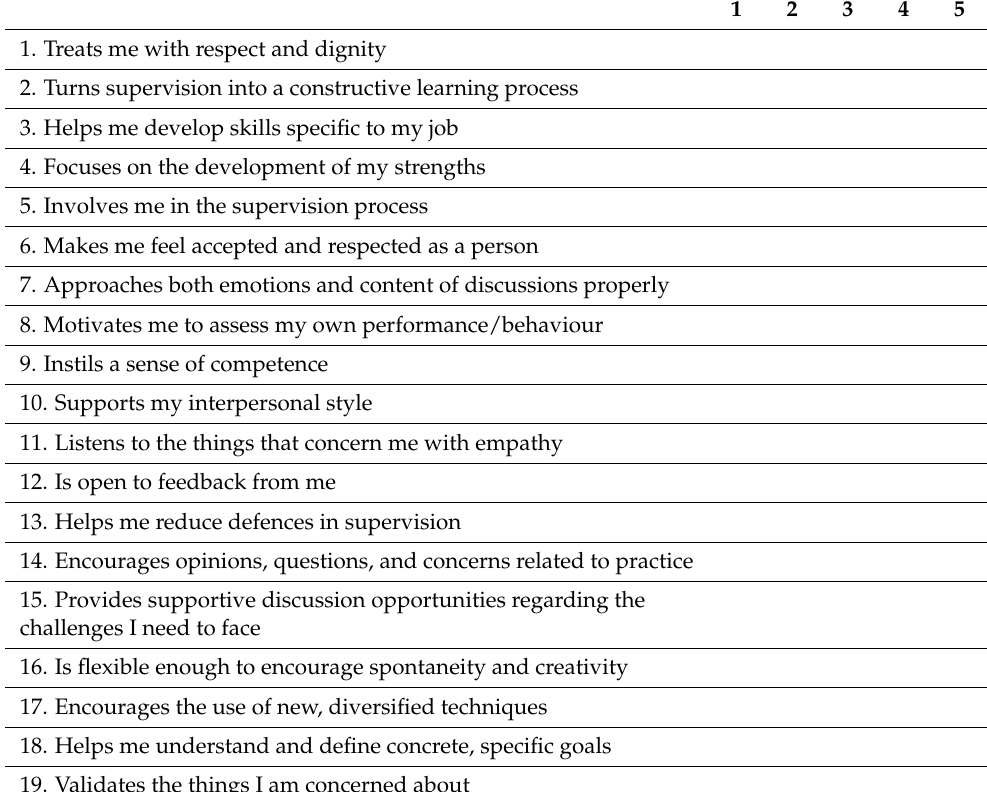
Table A2. 1—very rarely/2—rarely/3—sometimes/4—frequently/5—very